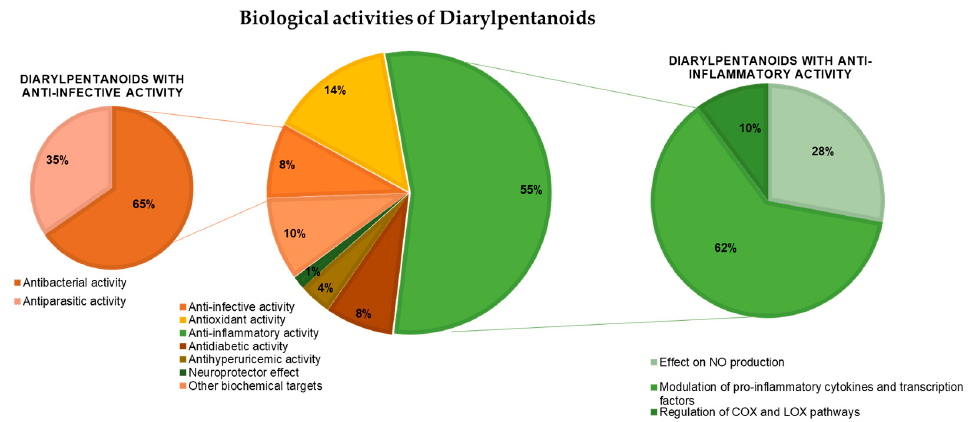
Figure 20. Distribution of the diarylpentanoids according to biological activity.